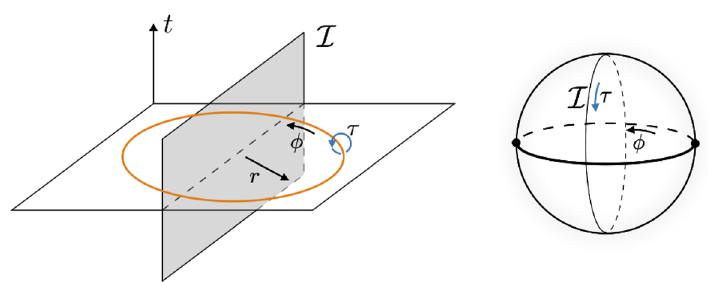
Figure 1 . (Left) A codimension-one conformal interface I and the entangling surface (within the constant time slice t = 0) in the 4 d Euclidean spacetime R 4 . The (cid:28) direction (blue arrow) corresponds to the modular (cid:13)ow. (Right) The conformal interface extends along the equator S 3 at (cid:30) = (cid:25)= 2 of the 4-sphere S 4